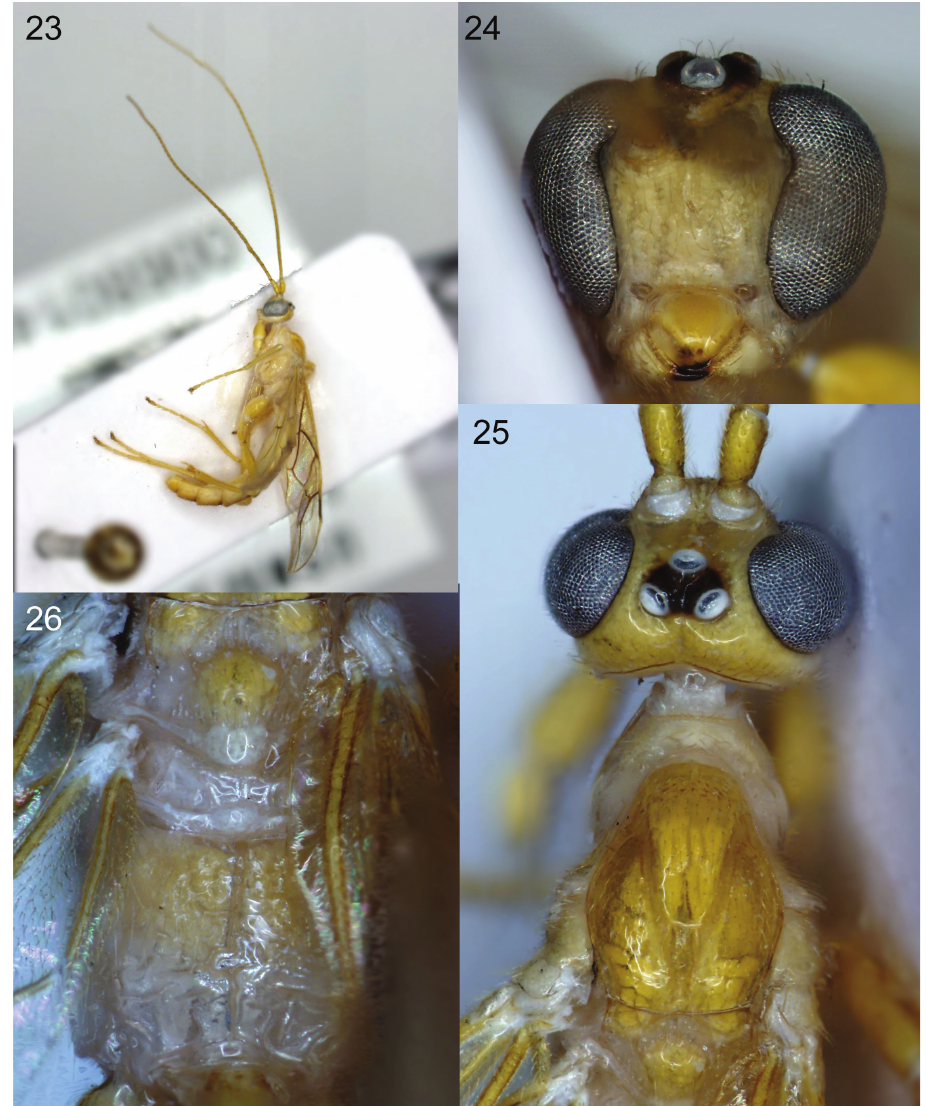
Figures 23–26. Colastomion crambidiphagus sp. n. holotype, Cell^D® light photomicrographs. 23 Habi- tus, lateral view 24 face 25 head and anterior mesosoma, dorsal view 26 propodeum. Paratypes: 1 female, Papua New Guinea, Madang Province, Wanang, 16-Feb-2007, 145°10.910'E, 5°13.853'S, 100m, ex caterpillar feeding on Merremia peltata (L.) Merr. (Convolvulaceae) (voucher USNM ENT 00680134; BOLD ASQSP135-08; Gen- bank JF963127); 1 female, Papua New Guinea, Madang Province, Wanang, 20-Jun- 06, 145°10.910'E, 5°13.853'S, 100m, ex caterpillar feeding on Merremia peltata (L.) Merr. (Convolvulaceae) (voucher USNM ENT 00680173, no sequence